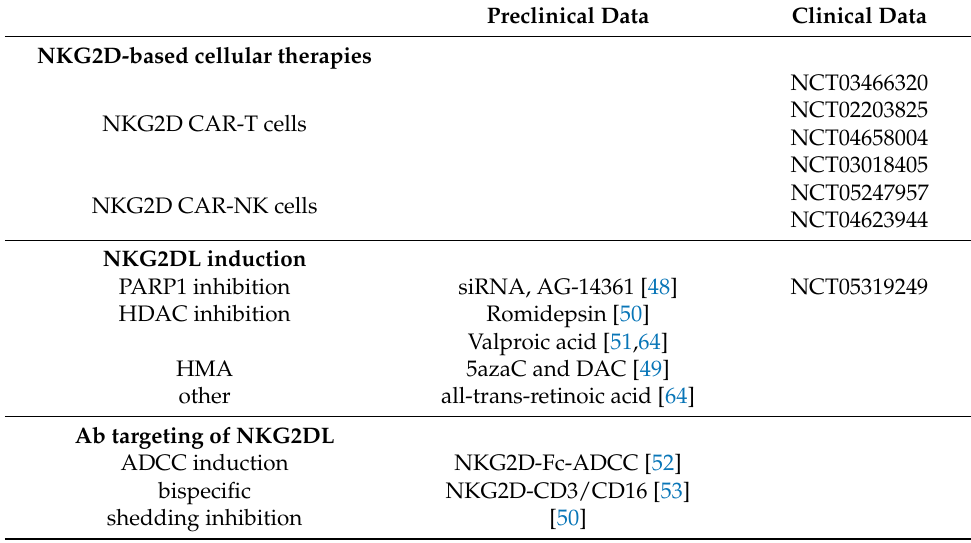
Table 1. Immunotherapies targeting NKG2DL in AML. Preclinical Data Clinical